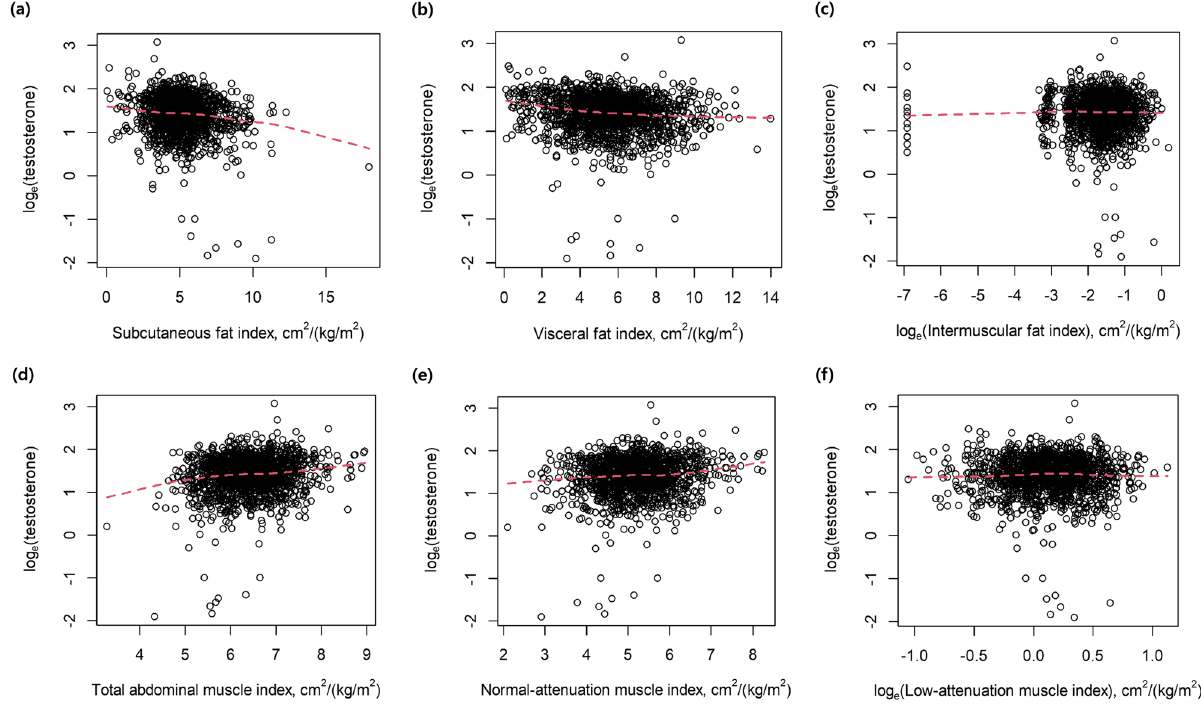
Figure 2. Scatter plots to show the association between log e -transformed testosterone and individual body composition parameters. ( a ) subcutaneous fat index, ( b ) visceral fat index, ( c ) intermuscular fat index, ( d ) total abdominal muscle index, ( e ) normal-attenuation muscle index, and ( f ) log e (low-attenuation muscle